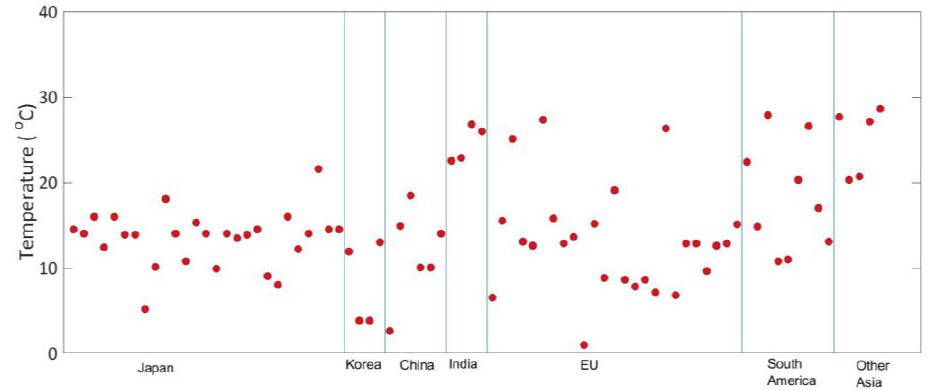
Figure 10. Minimum seawater temperatures around the world.